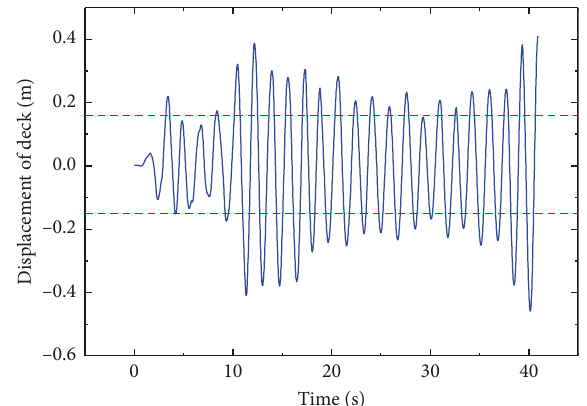
Figure 8: Longitudinal displacement of the deck.